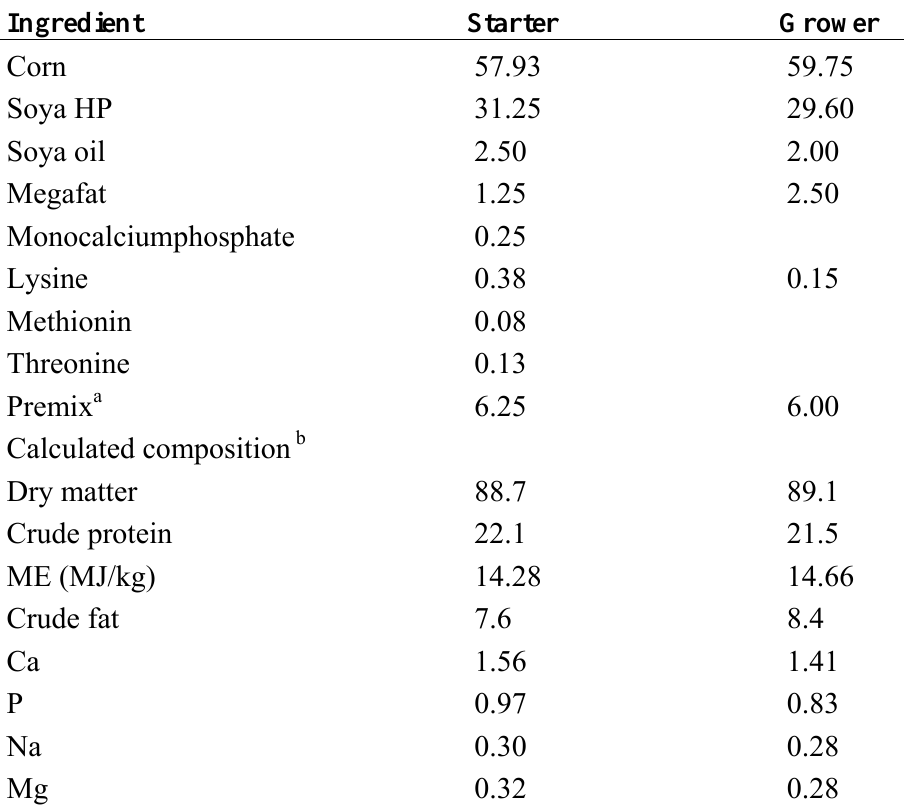
Table 1. Composition of the basal experimental diet